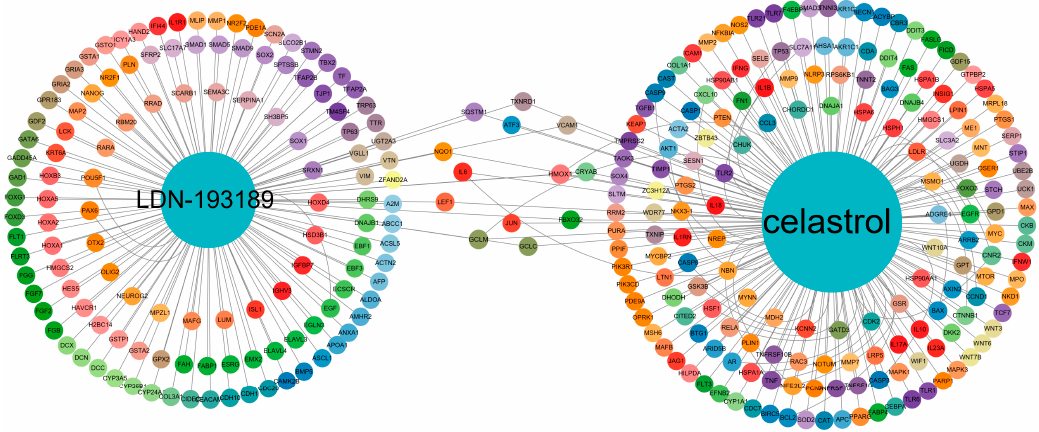
Figure 4. Construction of predicted drug–target gene interaction network.